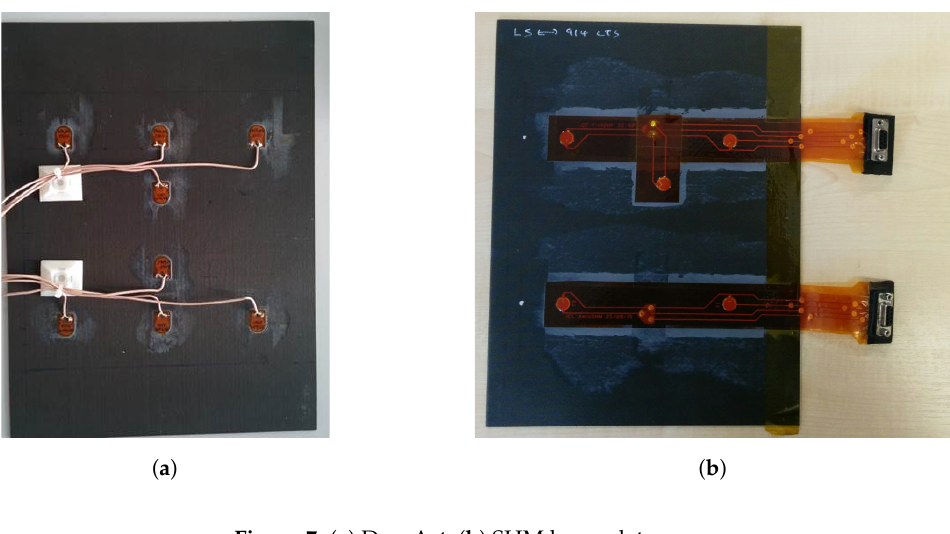
Figure 7. ( a ) DuraAct; ( b ) SHM layer